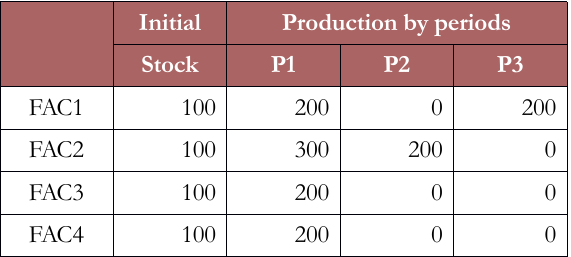
Table 3. Initial stock and production